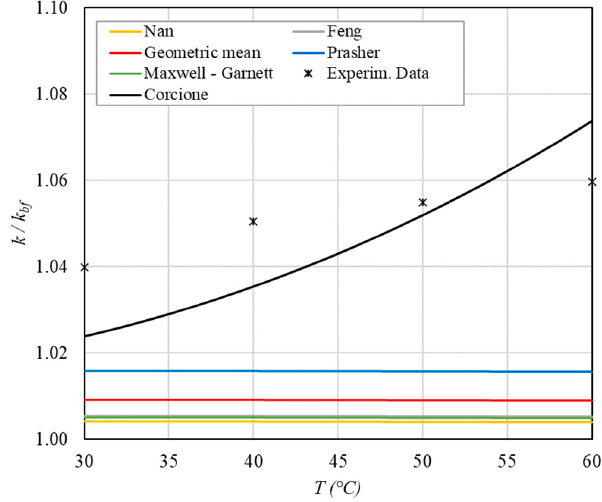
Figure 8. Increase in thermal conductivity versus temperature for ϕ = 0.17%.